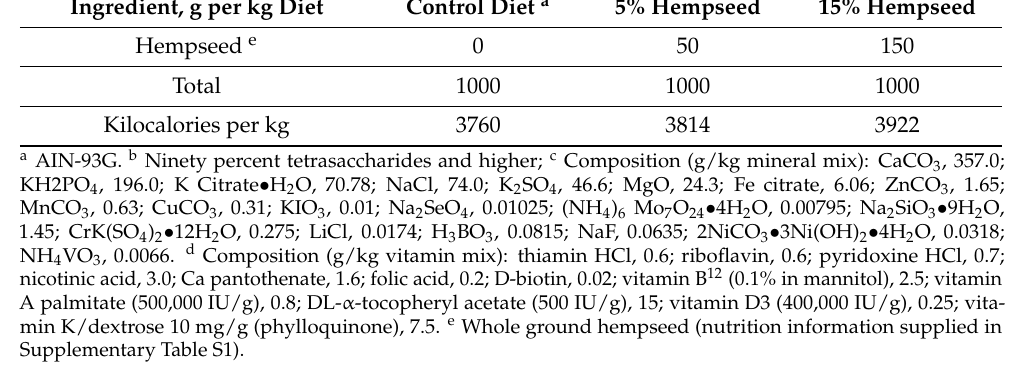
Table 1. Cont. Ingredient, g per kg Diet Control Diet a 5% Hempseed 15% Hempseed Hempseed e 0 50 150 Total 1000 1000 Kilocalories per kg 3760